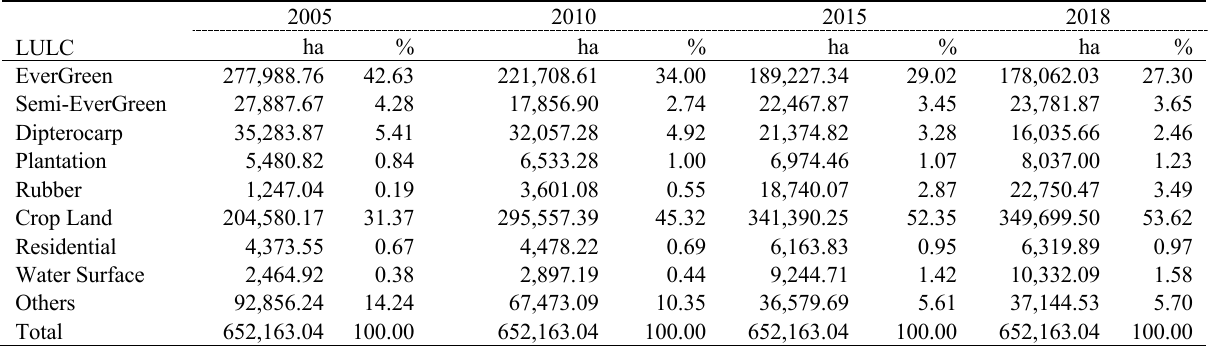
Table 3. Area of LULC categories over years